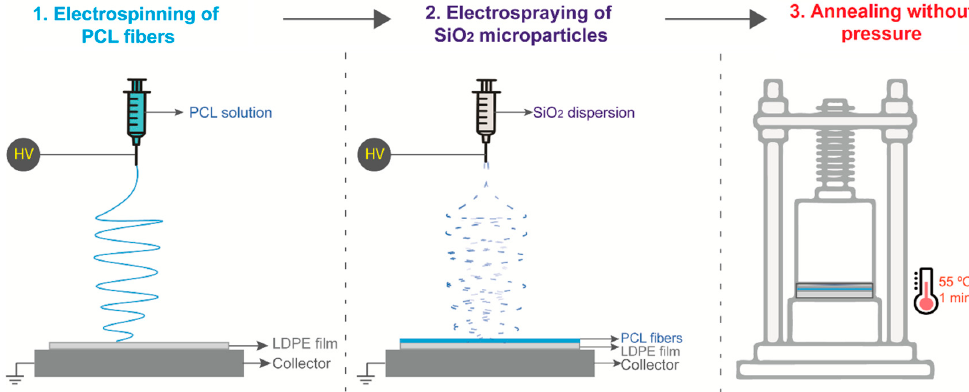
Figure 2. Schematic illustration of ( 1 ) deposition of the electrospun poly( ε -caprolactone) (PCL) fibers on the low-density polyethylene (LDPE) film, ( 2 ) deposition of the electrosprayed silica (SiO 2 ) microparticles on the LDPE/PCL film, and ( 3 ) thermal annealing of the LDPE/PCL/SiO 2 film with a hot press without applying pressure.